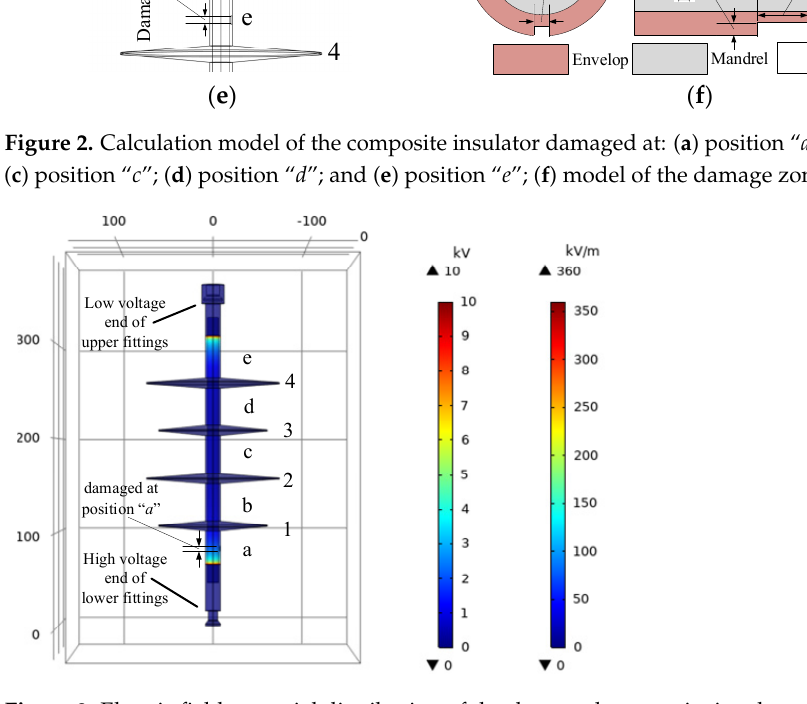
Figure 3. Electric field potential distribution of the damaged composite insulator at position “ a